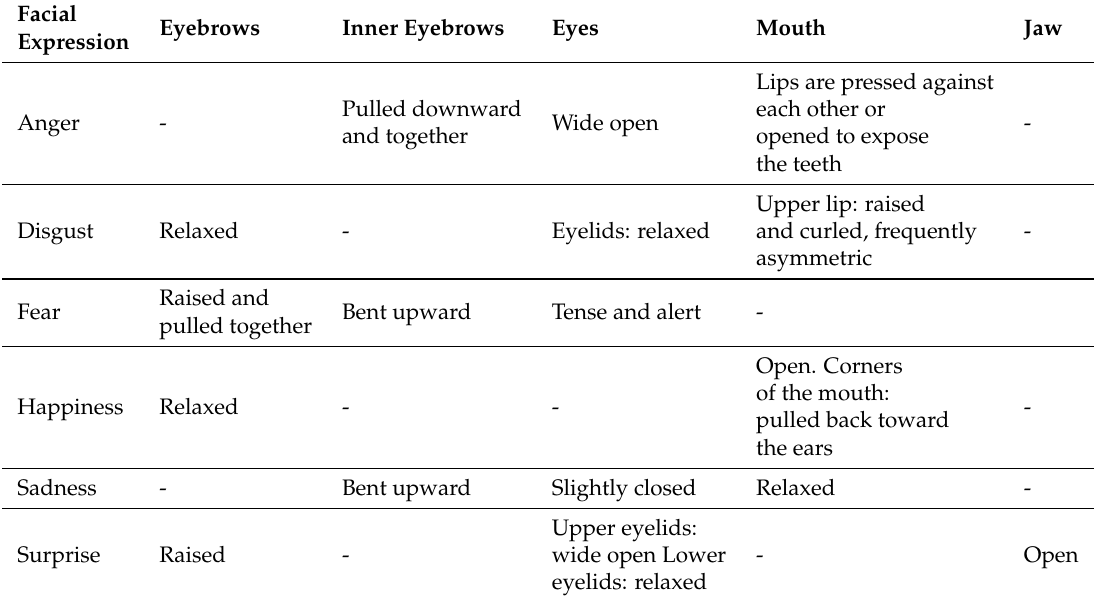
Table 3. Description of the six basic facial